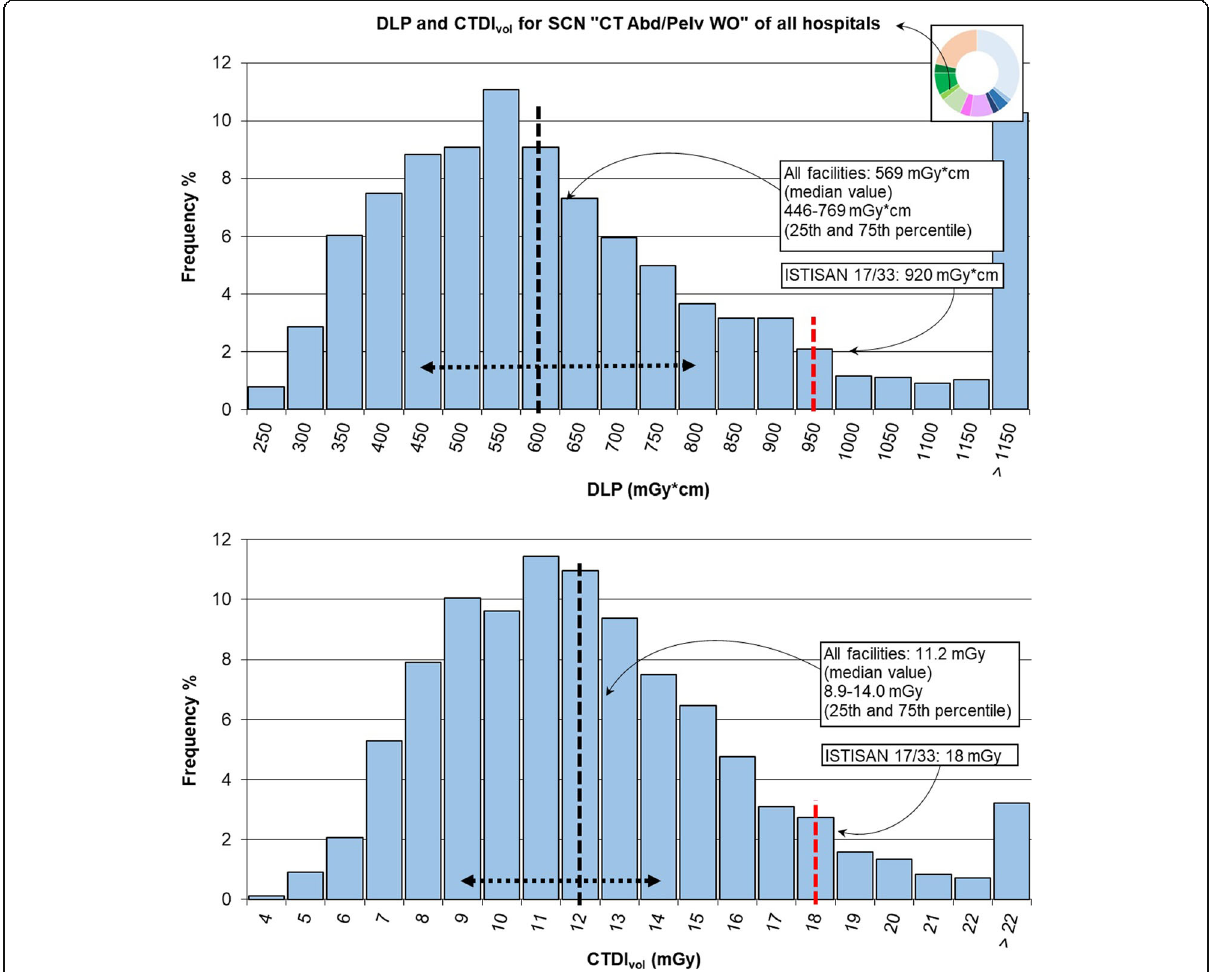
Fig. 6 Distribution of total dose-length product (DLP) and volumetric computed tomography dose index (CTDI vol ) for study common name (SCN) “ CT Abd/Pelv WO ” and comparison with values from ISTISAN 17/33 [13]. The median value and range between 25th and 75th percentile are shown in black dashed lines; the red dashed line reports the diagnostic reference level (DRL) provided by ISTISAN 17/33 [18]